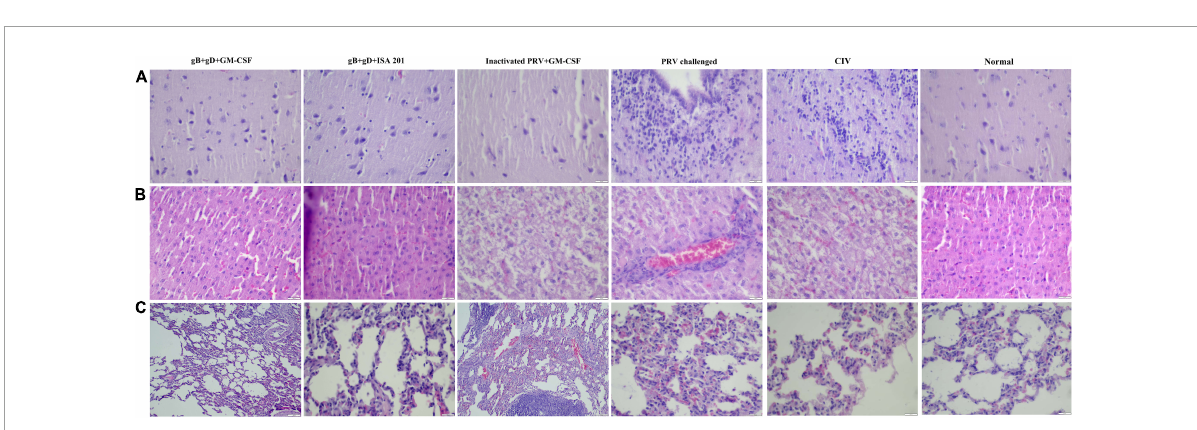
FIGURE7 Histopathology examination. In immunized rabbits at 14 days post-challenge, hematoxylin and eosin (H&E) staining was used to detect the pathological lesions of the brains (A) , livers (B) , and lungs (C) from the gB + gD + GM-CSF, gB + gD + ISA 201, inactivated PRV + GM-CSF, PRV-challenged, CIV and the normal groups. Tissues were sectioned into 5- µ m slices. Scale bar: 100 µ